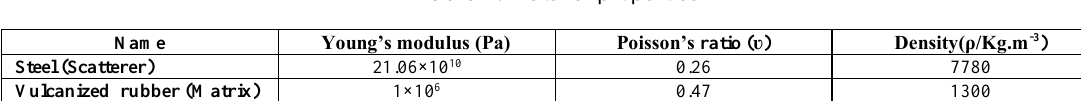
Table 2. Material